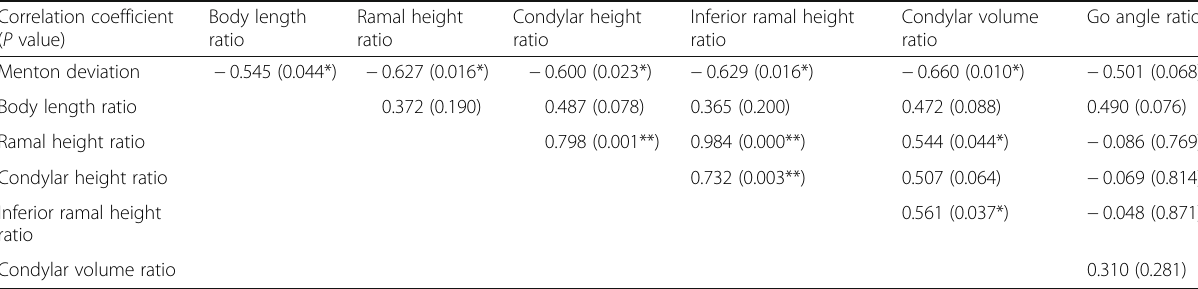
Table 5 Correlations between the measurements of mandibular morphology in the FA